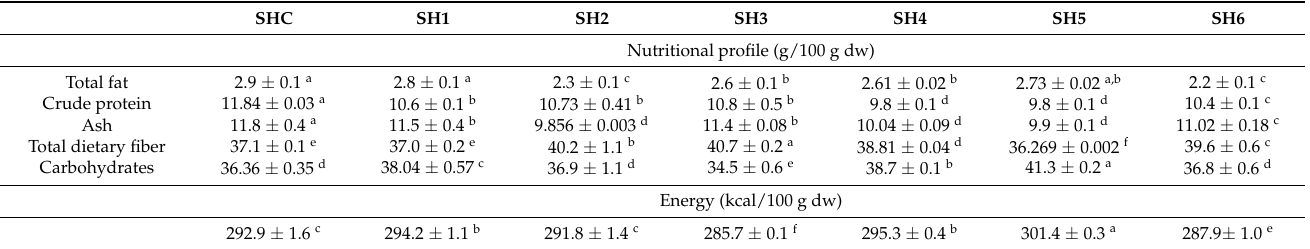
Table 3. Nutritional profile and energy content of Scolymus hispanicus leaves in relation to fertigation regime (Mean ±